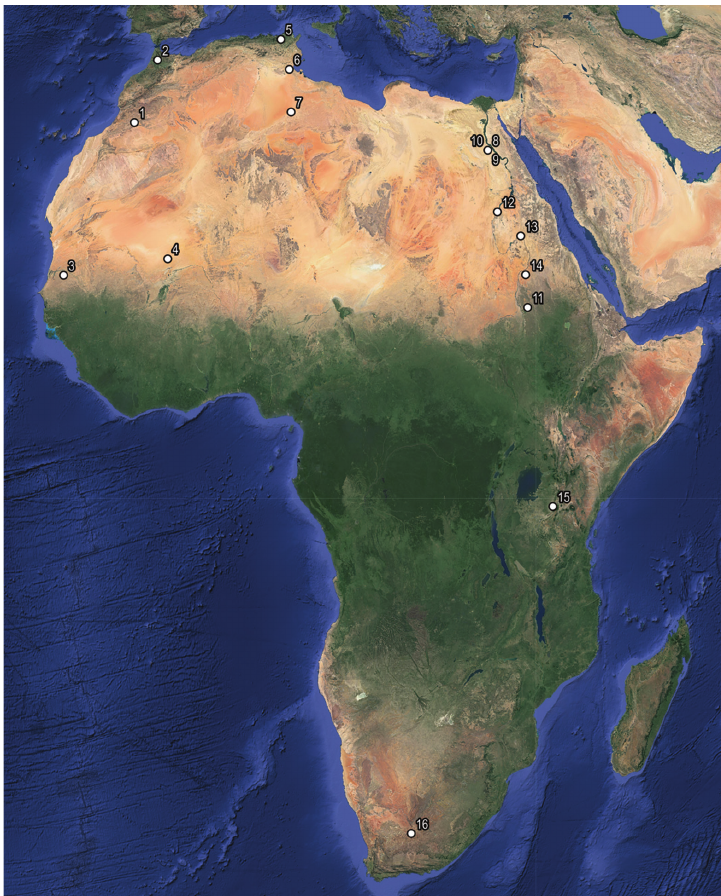
Figure 2 Map of Africa Morocco, Wadi Draa. Wadi Draa Archaeological Project.